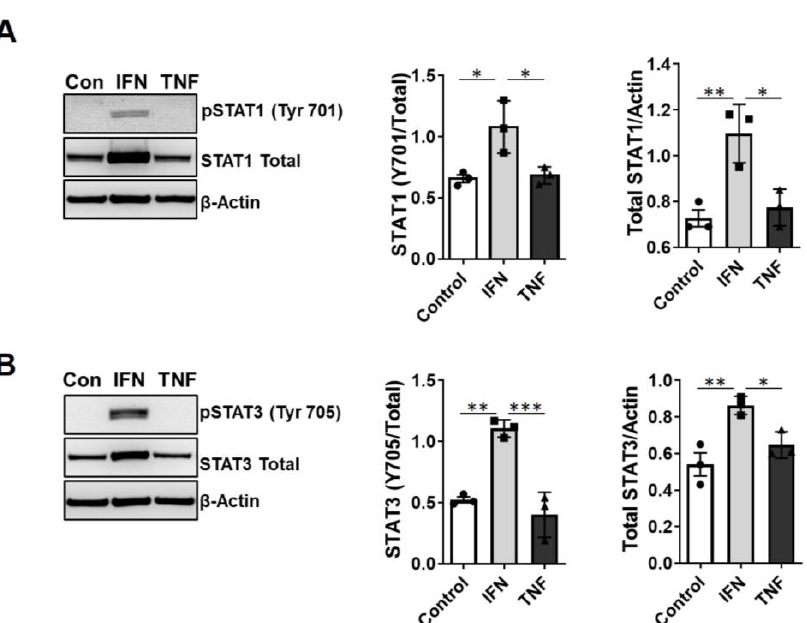
Figure 8. In vitro treatment of macrophages with IFN- γ increases phosphorylated or total levels of STAT1 or STAT3. ( A , B ) Raw 264.7 macrophages were exposed to IFN- γ (10 ng/mL) or TNF- α (10 ng/mL), and cell extracts were prepared using RIPA buffer (see Section 4). Proteins in macrophage extracts (20 μ g) were resolved with SDS-PAGE and analyzed by Western blot for phosphorylated and total levels of ( A ) STAT1 and ( B ) STAT3 after IFN- γ or TNF- α treatment. Untreated cell extracts were used as controls. Data shown are mean ± SEM ( n = 3) and these data underwent 1-way ANOVA analysis with Brown–Forsythe and Welch’s corrections for multiple comparisons; p < 0.05 was considered to be significant. *, p < 0.05; **, p < 0.01, ***, p < 0.001. Each solid circle, square, or triangle represent each experiment analysis (biological replicates) within the group.